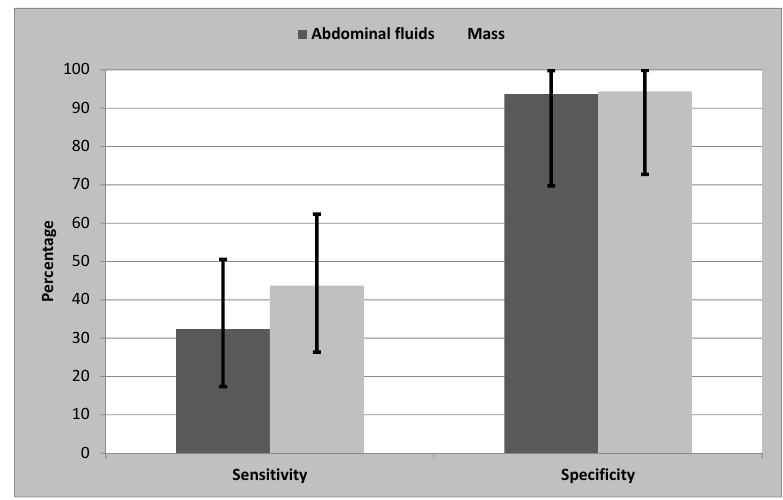
Figure 1. Bar graph showing the sensitivity and specificity of abdominal palpation for the detection of fluid and masses, when compared to ultrasonography. The black error bars denote the 95% confidence intervals.